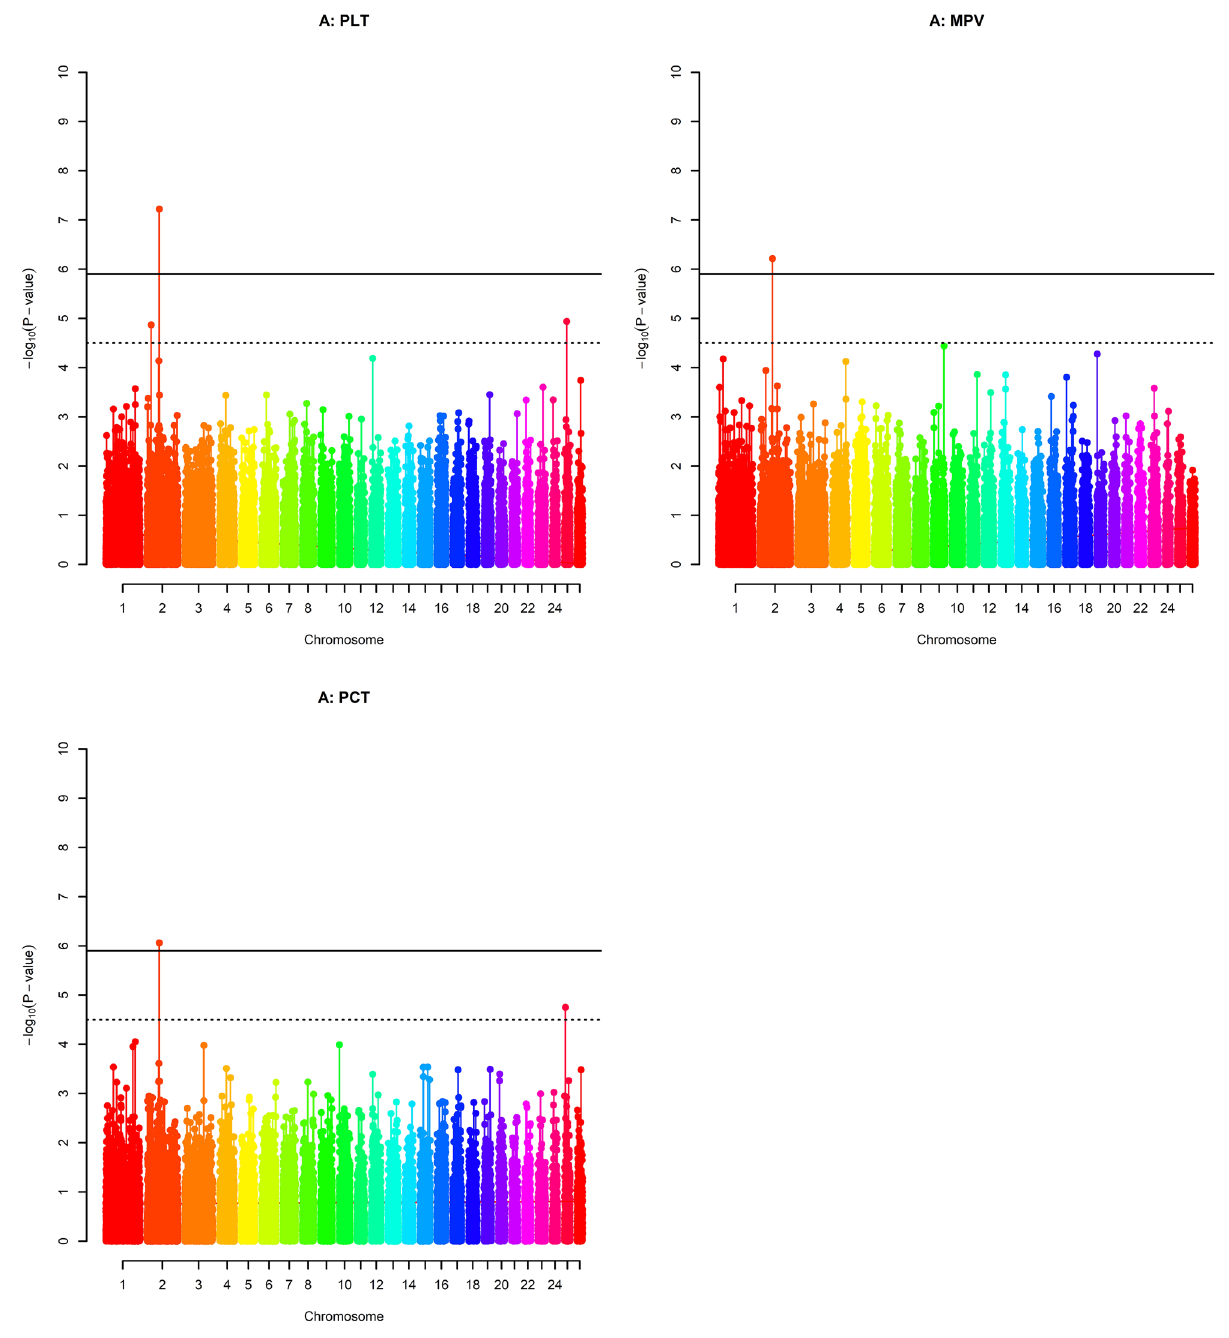
Figure 3. Manhattan plots of GWAS for thrombocyte, platelet, traits. A red dashed line represents the Bonferroni genome-wide significance level and a black dashed line represents the chromosome-wide significance level. Platelets count ( A ), mean platelet volume ( B ), procalcitonin ( C